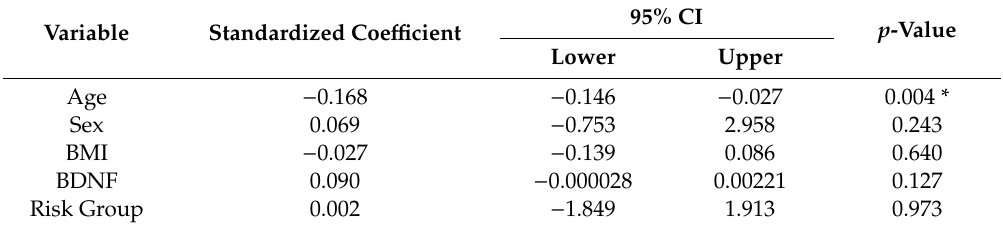
Table 3. Multivariable linear regression with Barratt Impulsivity Scale score ( n = 293).